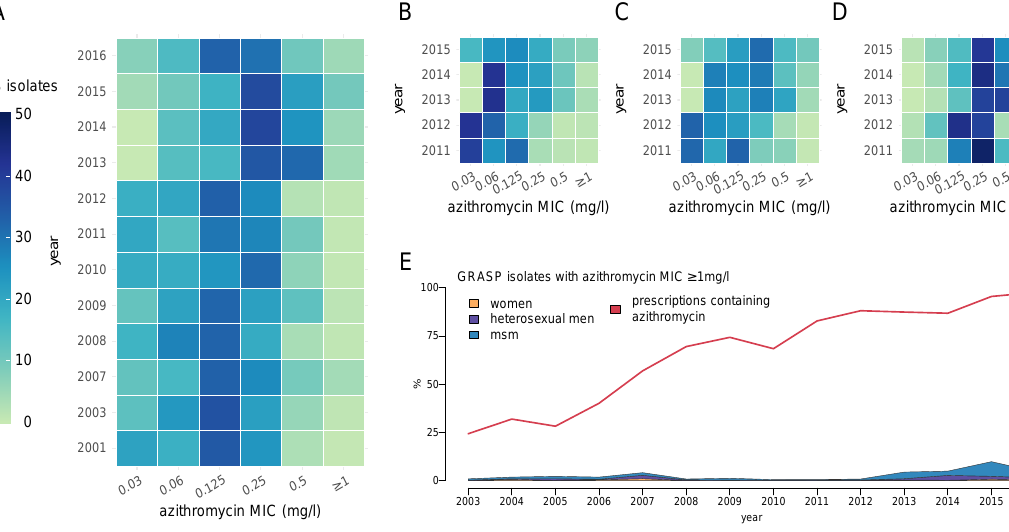
Figure 6. Heat maps showing the azithromycin MIC distribution of N. gonorrhoeae in the UK over time: ( A ) from all GRASP samples; ( B ) in women; ( C ) in heterosexual men and ( D ) in MSM; ( E ) Proportion of gonococcal isolates in GRASP showing resistance to azithromycin over time, split by gender and male sexual behaviour compared with the proportion of prescriptions that include azithromycin. Note that the MIC values in 2013 and 2014 have been adjusted upwards by one dilution from those published in GRASP to compensate for poor growth on the agar medium